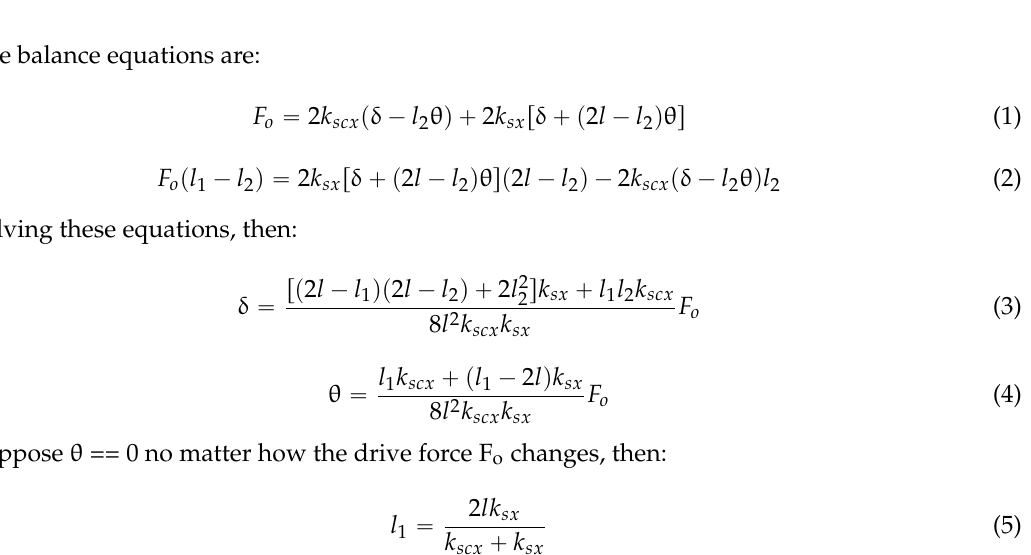
Figure 3. Simplified force model of improved sense frame in the x-axis direction.